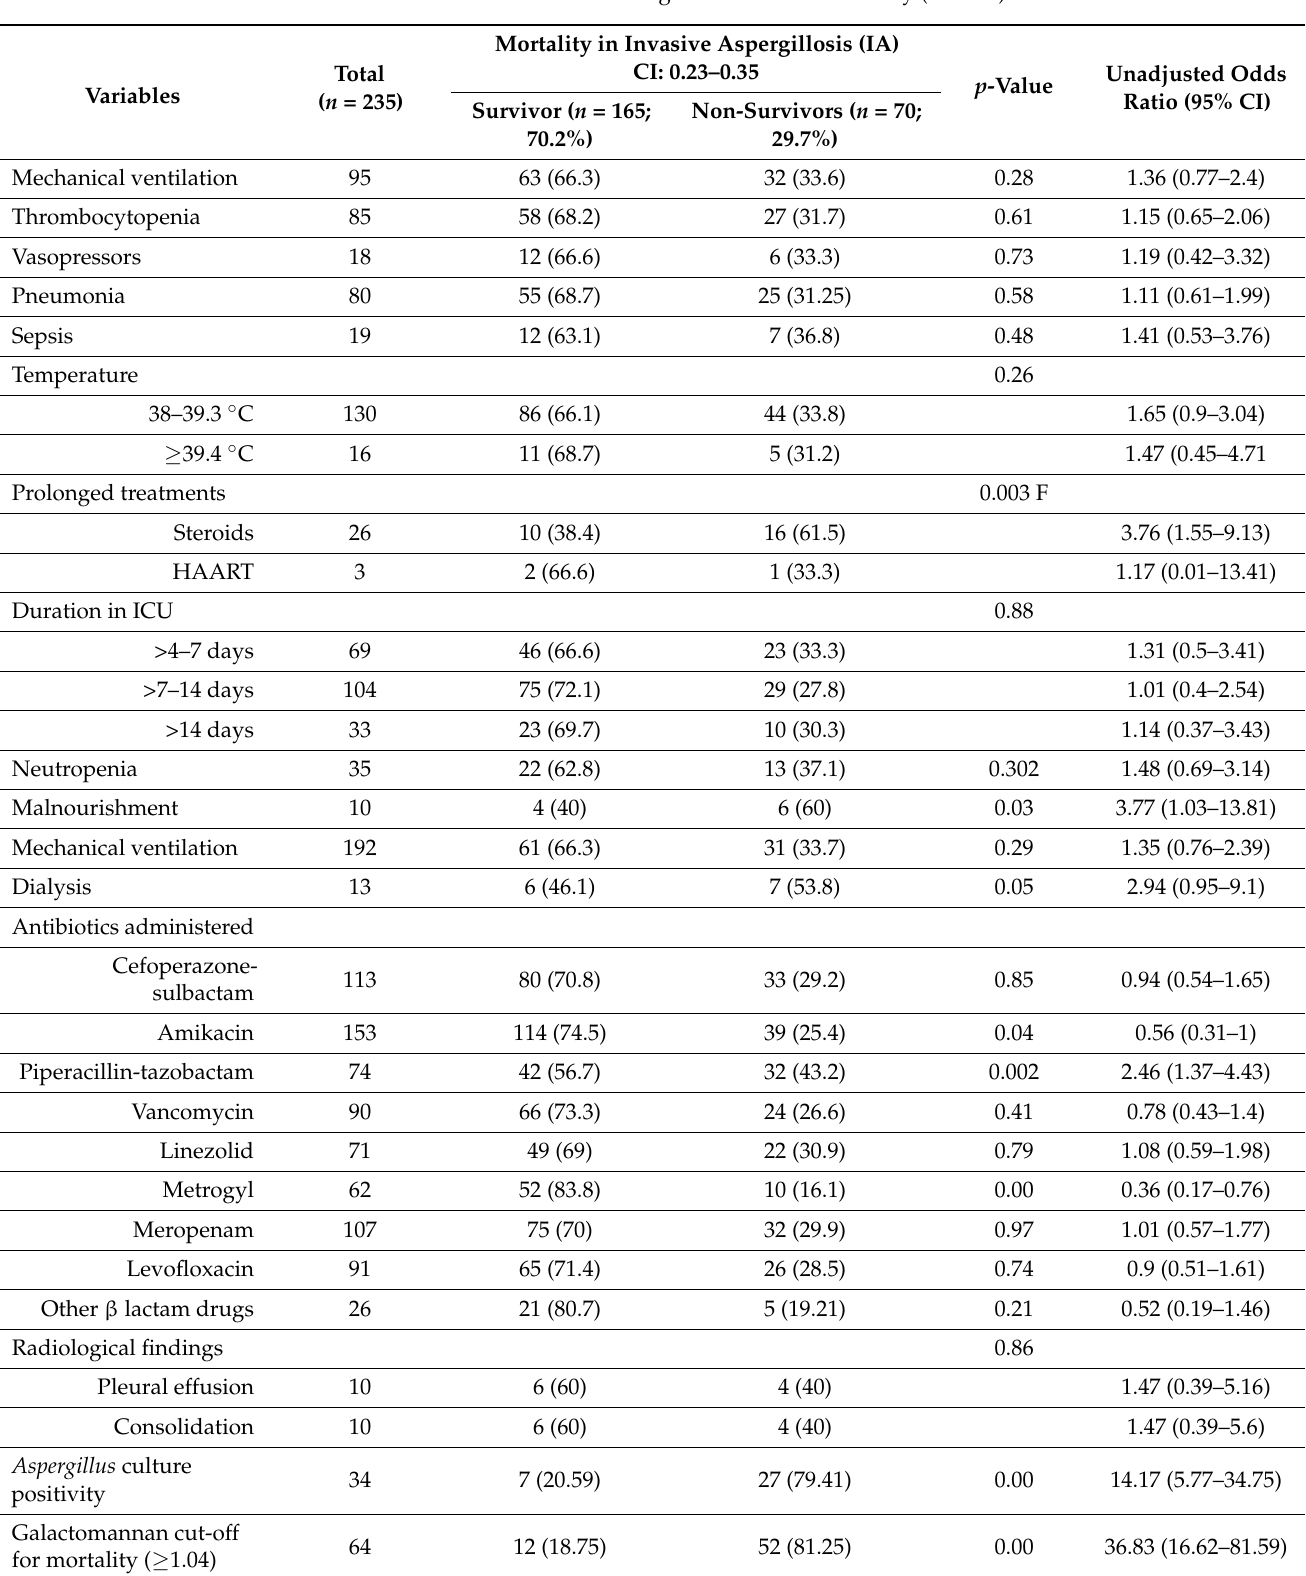
Table 2. Clinical characteristics during ICU admission and stay ( n =